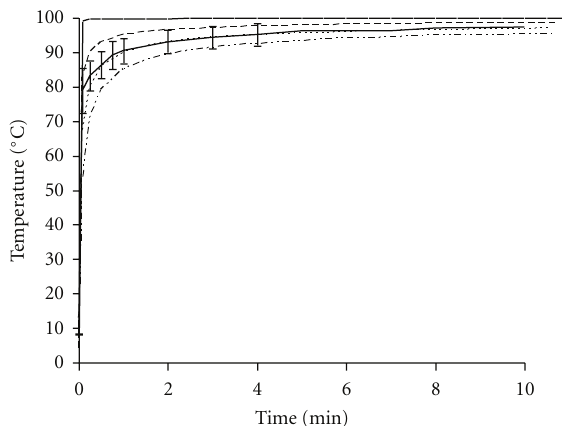
Figure 2: (Estimated) Temperature profiles of the surface of a chicken fillet during boiling in water. Estimated: thin —: at the surface; – –: at 0.25 mm depth; ---: at 0.5 mm depth; – ·· – : at 0.75 mm depth. Measured: thick —: surface of chicken fillet including error bars for stdev.